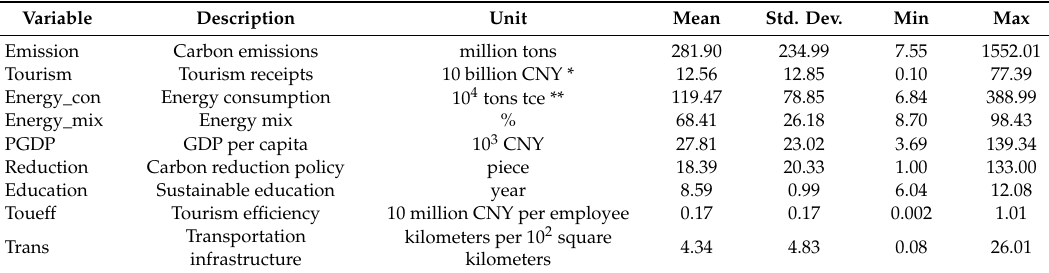
Table 1. Description and summary statistics of the